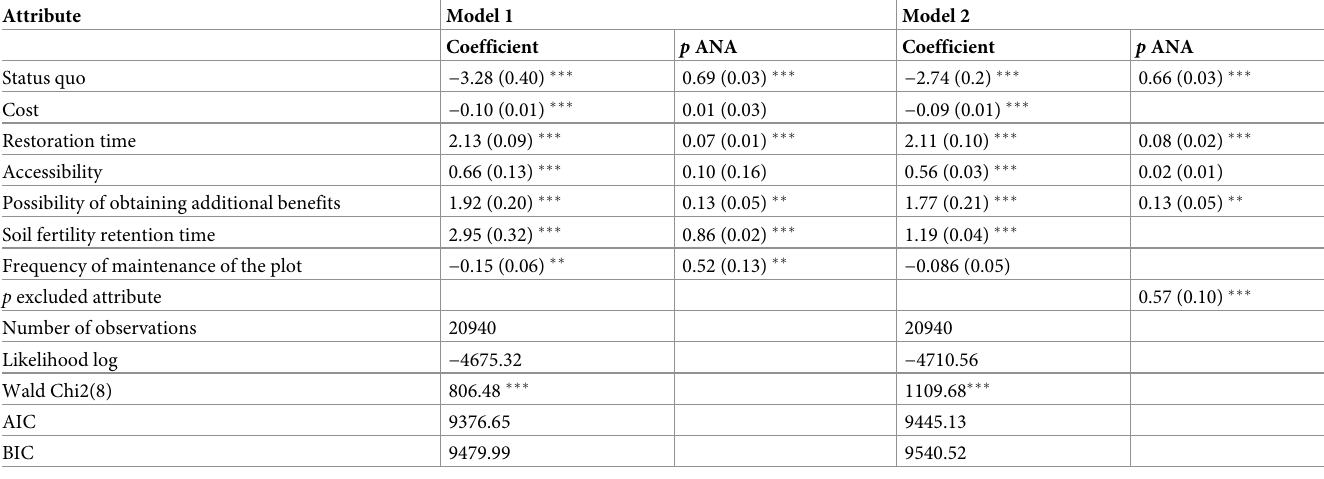
Table 7. Results of endogenous attribute attendance model.